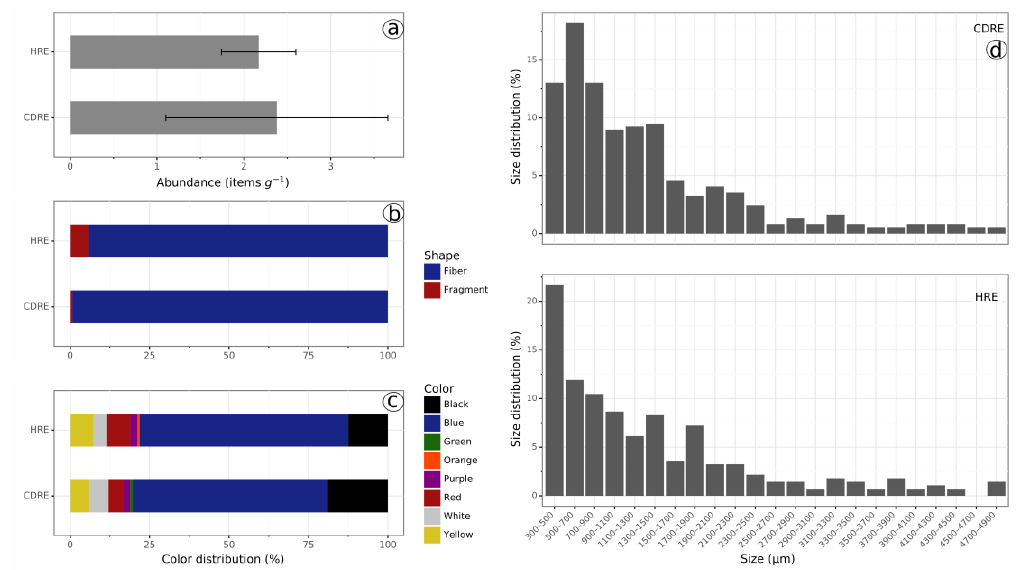
Figure 4. Microplastic characteristics in the undulate venus clam Paratapes undulatus from Han River Estuary (HRE) and Cu De River Estuary (CDRE): ( a ) abundance; ( b ) shape distribution; ( c ) color distribution; and ( d ) size distribution.